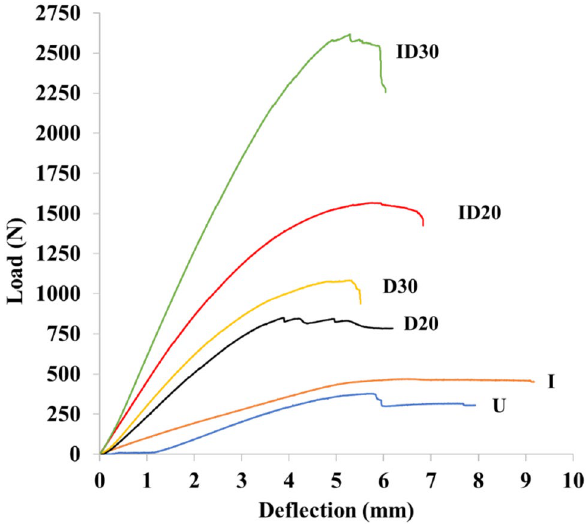
Figure 4. Load–deflection curves of modified inner part of oil palm trunk. U = Untreated; I = Impregnation; D20 and D30 = densification with compression ratio (CR) 20% and 30%, respectively; ID20 and ID30 = compregnation with CR 20% and 30%, respectively.